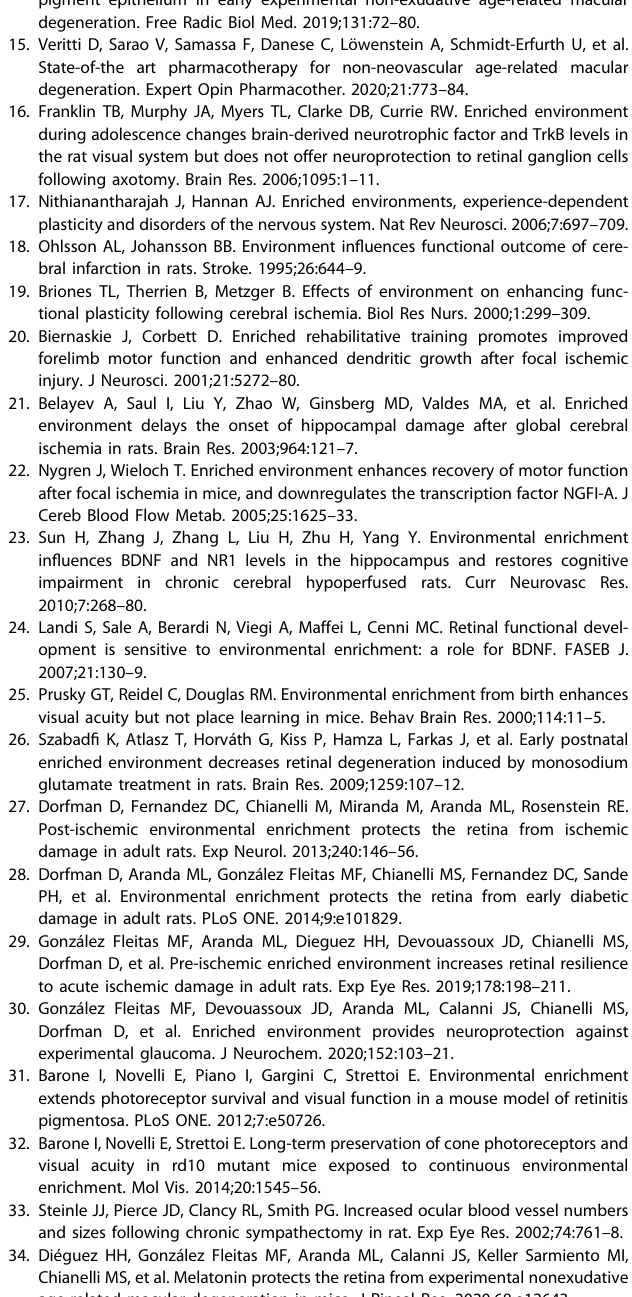
Fig. 6 Effect of visual stimulation (VS) on the retinal function and temporal RPE structural alterations and visual behaviour tests at 10 weeks post-SCGx. A Experimental protocols. B SCGx induced a signi fi cant decrease in ERG a-wave amplitude in animals exposed to non- visual stimulation (NVS), whereas VS exposure since 48 h post-SCGx completely prevented the decrease in this parameter (representative traces shown in C ). D – I Exposure to VS totally prevented the SCGx-induced decrease in the melanin content (arrow) and RPE65- immunoreactivity (arrowhead) and protein levels at the temporal RPE in SCGx-treated eyes from animals exposed to NVS. Shown are representative photomicrographs from 5 eyes/group, at 800 μ m temporally from the ONH. OS photoreceptor outer segments, RPE retinal pigment epithelium, Chr choroid. Scale bars = 25 μ m. Data are mean ± SEM ( n : 5 eyes per group), ** P < 0.01 vs. sham-treated eyes from animals exposed to NVS; a: P < 0.01 vs. SCGx-treated eyes from animals exposed to NVS, by Tukey ’ s test. Data are mean ± SEM ( n : 5 homogenates per group), ** P < 0.01 vs. sham-treated eyes from animals exposed to NVS, by Tukey ’ s test. J – L VS completely preserved the performance in the looming test, the visual cliff, and the virtual visual cliff tests. The time spent at the borders of the virtual visual cliff arena signi fi cantly increased in sham-treated animals housed in VS and SGCx-treated animals housed in NVS and VS. ** P < 0.01 vs. sham-treated eyes from animals exposed to NVS; a: P < 0.01 vs. SCGx-treated eyes from animals exposed to NVS, by Tukey ’ s test ( n : 12 animals per